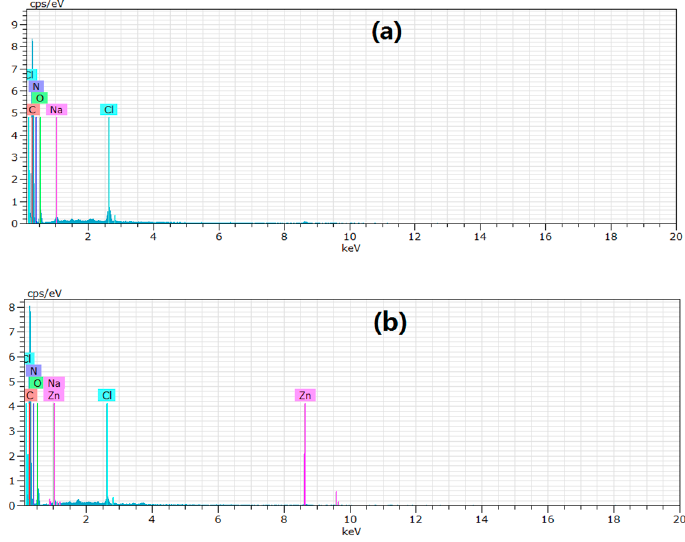
Figure 13. EDX analysis of XSBLAC before ( a ) and after ( b ) adsorption zinc(II).